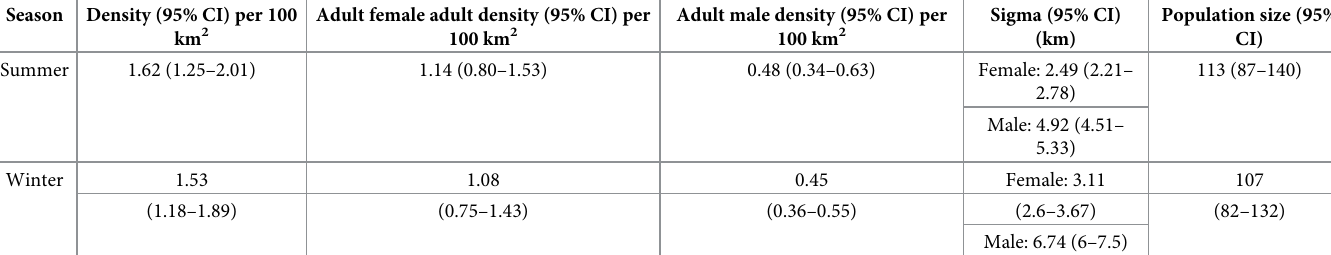
Table 1. Estimates of the Bayesian spatial capture-recapture model parameters. Sigma is the ranging scale parameter.